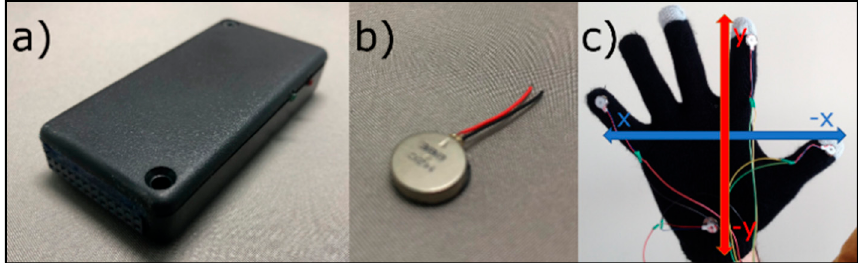
Figure 8. ( a ) Vibrotactile device VITAKI; ( b ) Vibrotactile actuator used by VITAKI; ( c ) Coordinate axis in the user’s palm formed by four vibrotactile actuators.